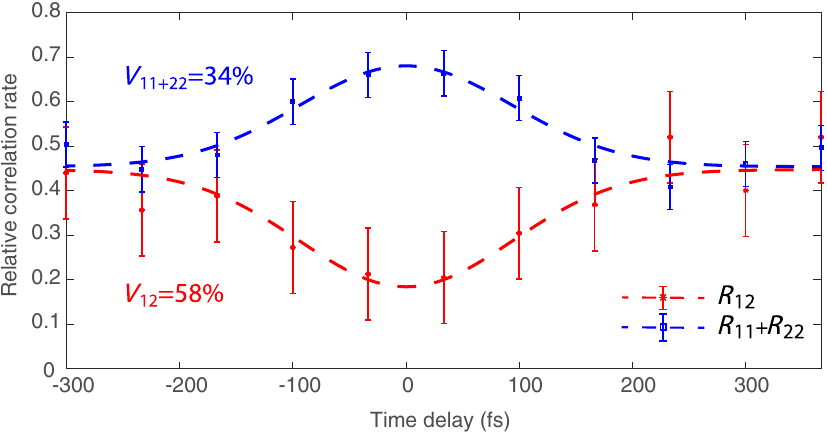
FIG. 4. Relative spatial correlation ratios as a function of the time delay between the two arms of the HOM interferometer when the polarization states of the twin beams are VV . The red stars and blue squares correspond to correlations between twin images and within single images, respectively. The dotted curves correspond to nonlinear fits of the experimental data. These curves exhibit a HOM dip and a HOM maximum with visibilities of 58% and 34%,